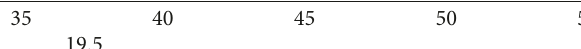
Figure 10: Stresses distribution of 13230 haulage roadway surrounding rock. Table 2: Numerical simulation stress conditions.